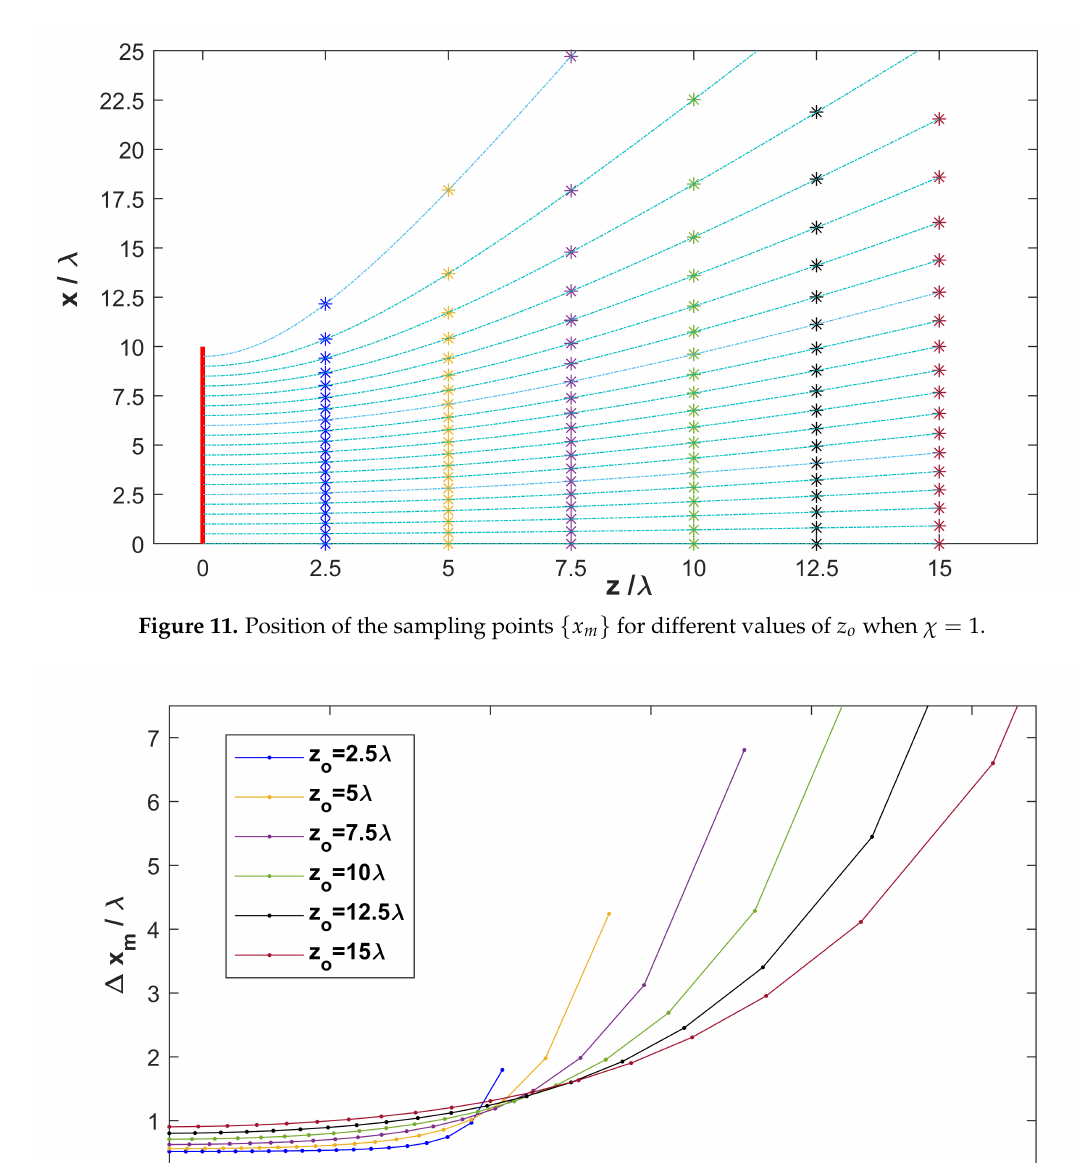
Figure 12. Diagram of